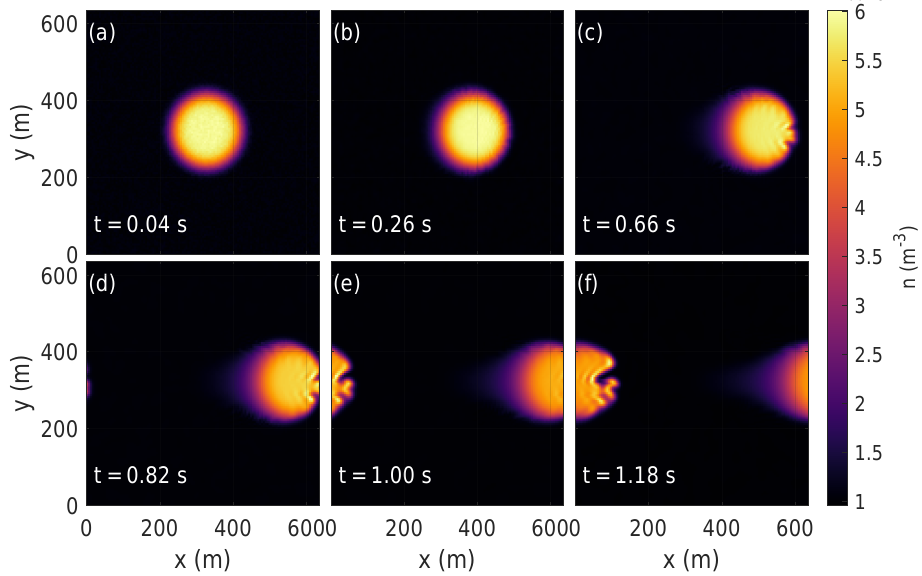
Figure 2. Density color plots of the 2D simulations showing the evolution of a plasma enhancement cloud in a highly collisional regime. The trough of the GDI-induced bifurcation becomes unstable to a secondary GDI. Panels ( e , f ) show the continuation of the secondary instability development emerging from the center of the plasma cloud. Note that since the neutral wind is fast, the cloud elongates in the ˆ x direction as the tail gets longer further in time. In the highly collisional regime, the plasma cloud structure is dominated by the development of the